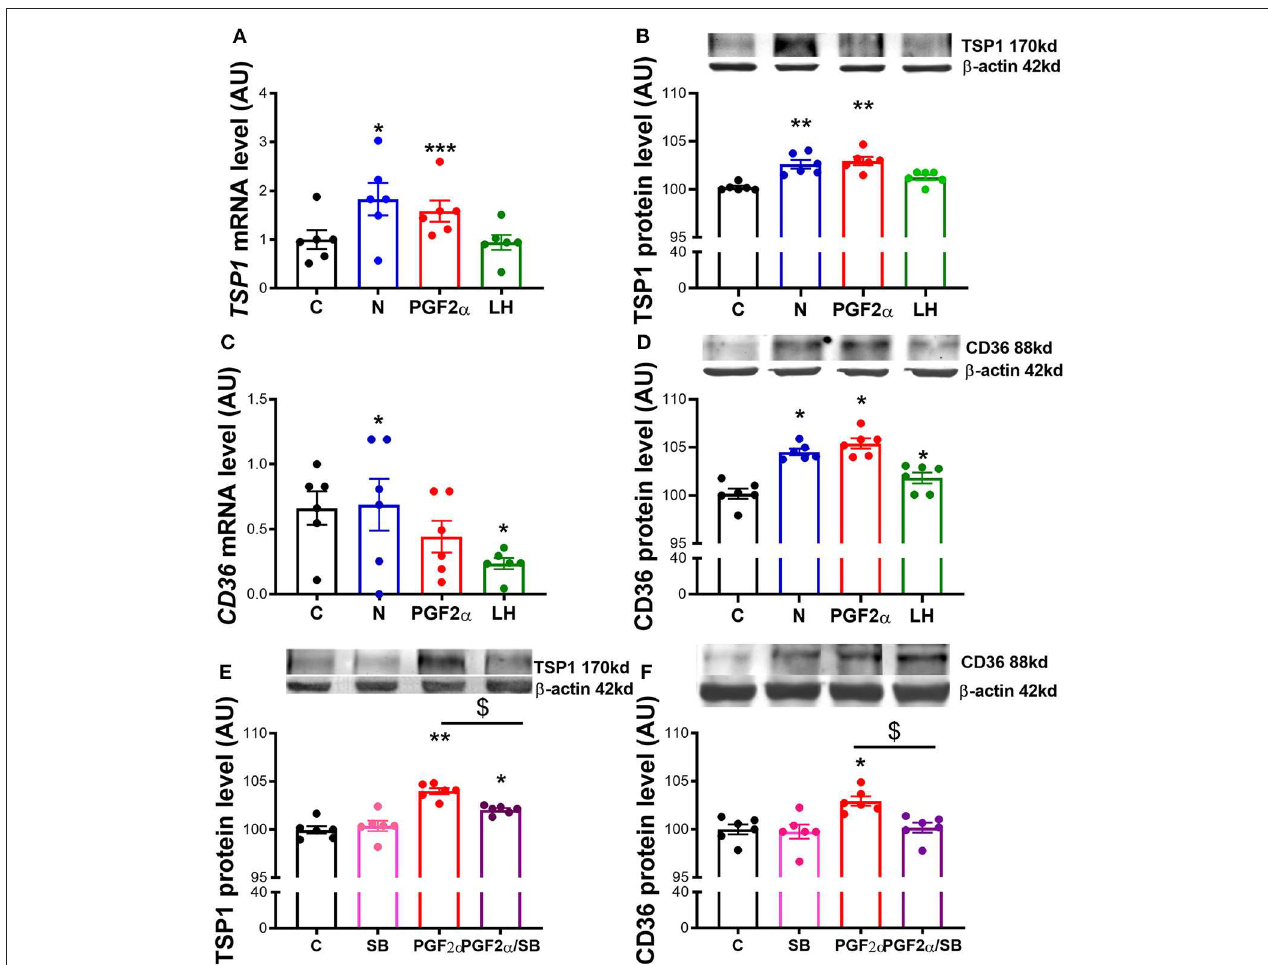
FIGURE 5 | Nodal crosstalk with TSP1 and CD36 in mid CL explants cultured in vitro. Expression of (A) thrombospondin 1 (TSP1) mRNA, (B) TSP1 protein, (C) cluster of differentiation 36 (CD36) mRNA and (D) CD36 protein after 24h culture: (i) no factor (C, negative control); (ii) Nodal (10ng/mL); (iii) prostaglandin F2 α (PGF 2 α 10 − 7 M); and (iv) luteinizing hormone (LH, 10ng/mL) ( n = 6). Expression of (E) TSP1 protein and (F) CD36 protein after 24h culture: (i) no factor (C, negative control); (ii) SB (10 µ M); (iii) PGF 2 α (10 − 7 M); and (iv) simultaneously SB (10 µ M) and PGF 2 α (10 − 7 M) ( n = 6). mRNA expression determined by real-time PCR, expression relative to b-2-microglobulin (B2MG) expression. Protein expression determined by western blot, upper panel: representative immunoblot; lower panel: densitometry of protein expression relative to β -actin expression. Values are expressed as means ± SEM in arbitrary units (AU). Statistical differences with regard to control are marked with asterisks (* p < 0.05; ** p < 0.01; *** p < 0.001); Statistical differences with regard to PGF 2 α are marked with dollars ( $ p <